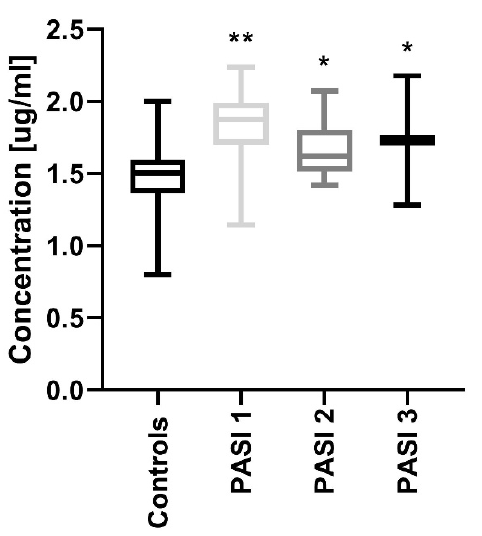
Figure 5. Comparison between PCSK9 concentrations depending on psoriasis area and severity index (PASI) after treatment and controls. * / ** means statistical significance with p < 0.05 / 0.01 respectively, compared to Controls.